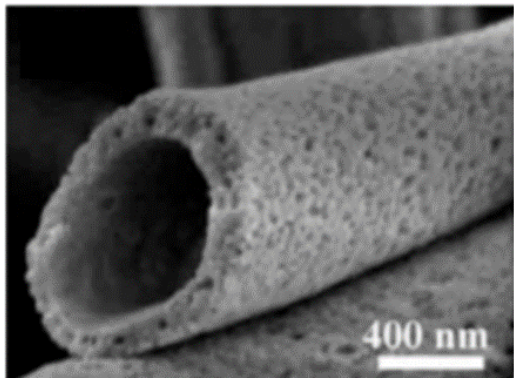
Figure 4. Scanning electron microscope (SEM) micrograph of an hollow nanofiber (adapted from [80], published by MDPI,